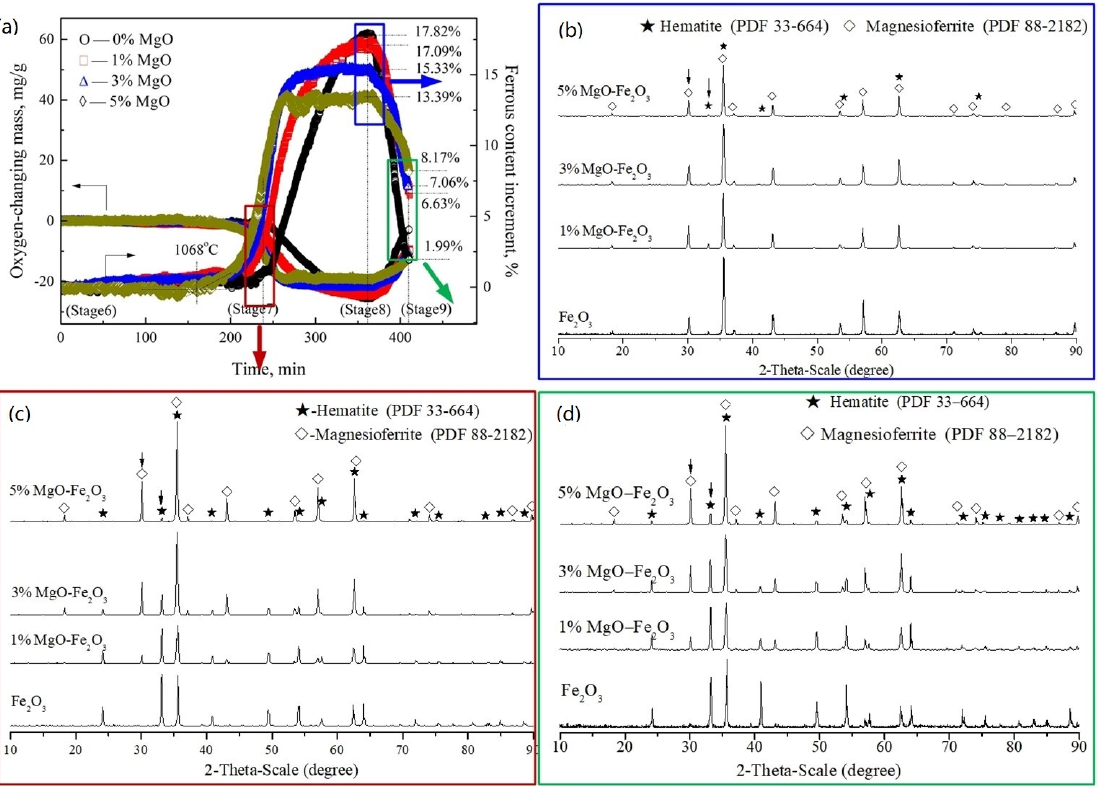
Figure 5. Effect of MgO addition on hematite in the temperature increasing and decreasing process (Stage 6 to Stage 9): ( a ) quantitative variations in oxygen and ferrous; ( b ) XRD patterns of Stage 7; ( c ) XRD patterns of Stage 8; ( d ) XRD patterns of Stage 9.